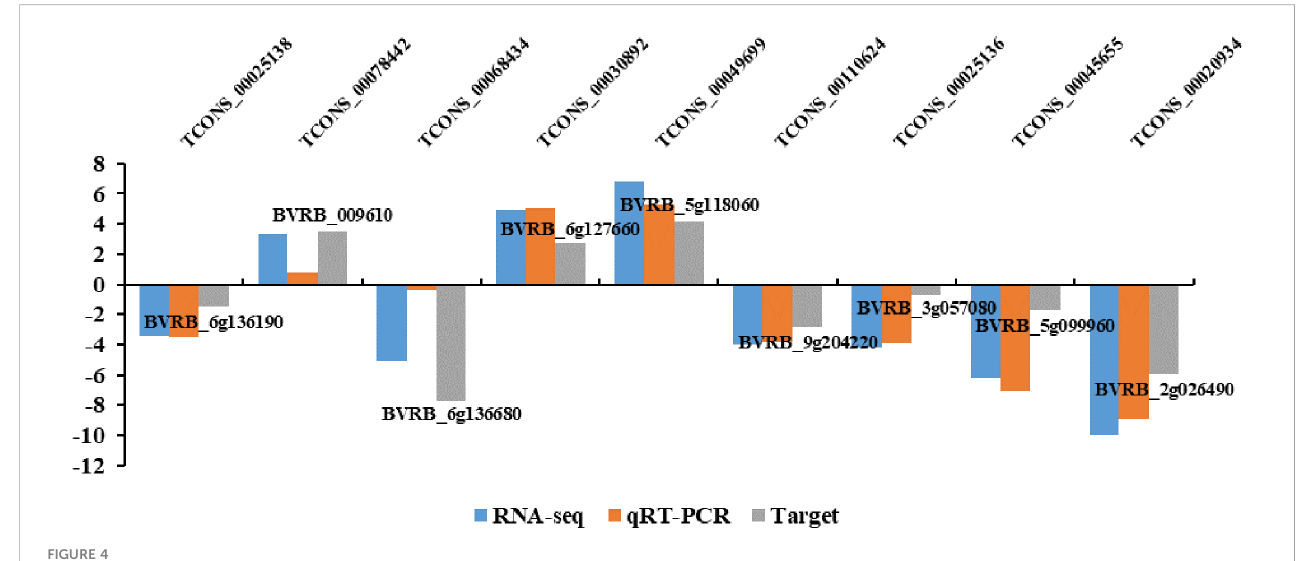
FIGURE 4 qRT-PCR veri fi cation for the nine lncRNAs and their target